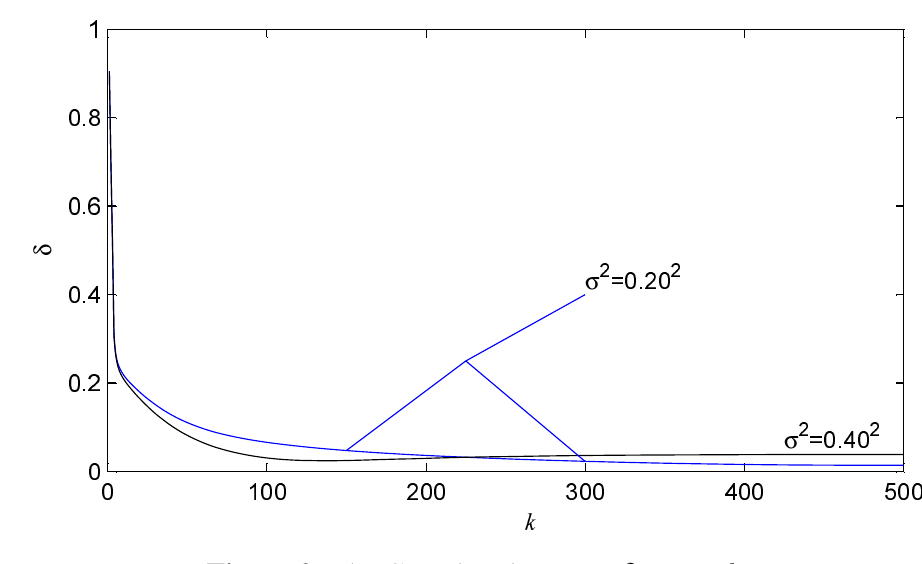
Figure 2. The GI estimation error δ versus k .